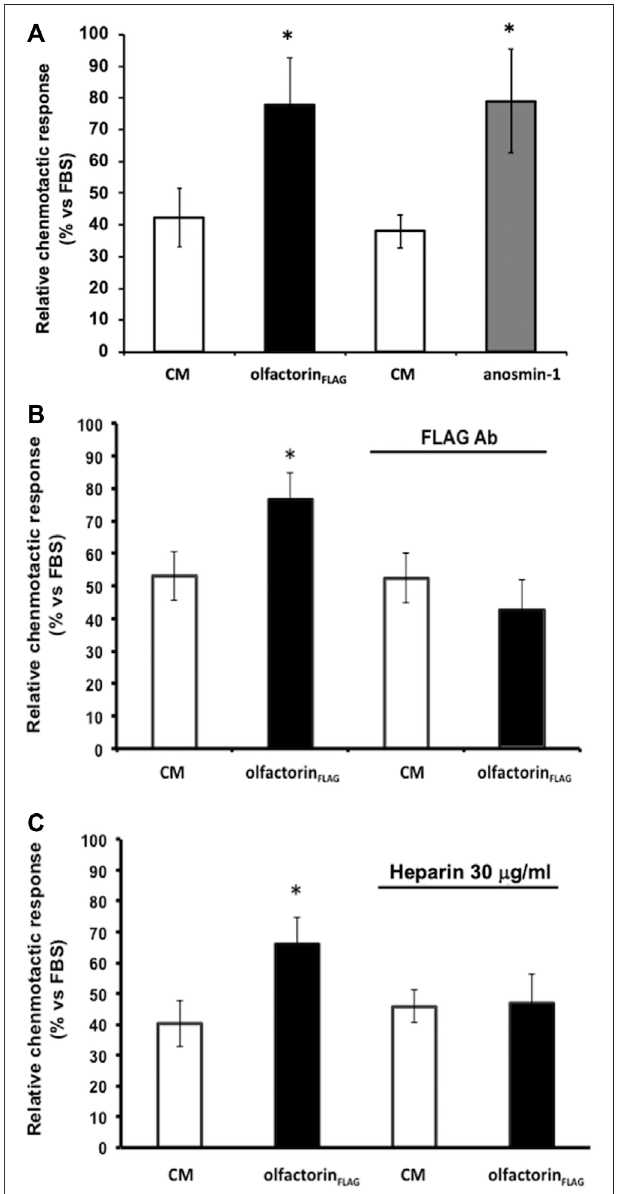
FIGURE 3 | Effects of the exposure to the olfactorin-enriched CM (olfactorin FLAG ) on the chemomigration of GN11 cells. Microchemotaxis experiments were performed in the Boyden ’ s chamber using the CM from COS-7 cells transfected with the empty vector (CM) or with pCMV SPORT6.1 PPT-FLAG-UMODL1 (the olfactorin-enriched CM; olfactorin FLAG ) or pMT21myc- ANOS1 (the anosmin-1-enriched CM; anosmin-1). (A) Comparison of the chemotactic effects exerted by olfactorin- and anosmin-1- enriched CMs on GN11 neurons. Internal controls for the procedure are represented by the chemotaxis to culture medium alone (DMEM) or culture mediumwith0.1%FetalBovineSerum(FBS)asgeneralchemoattractant.The results are expressed as the number of migrated cells per square mm of the porous membrane in 3 h. Mean ± SD from more than 4 – 6 independent experiments. * p < 0.05 vs respective CMs; ** p < 0.05 vs DMEM. (B) Effect of immunoneutralization with a monoclonal anti-FLAG antibody on GN11 cell chemomigration induced by olfactorin FLAG . (C) Involvement of HSPG in the chemotaxis of GN11 cells induced by olfactorin FLAG . The CM was ( Continued